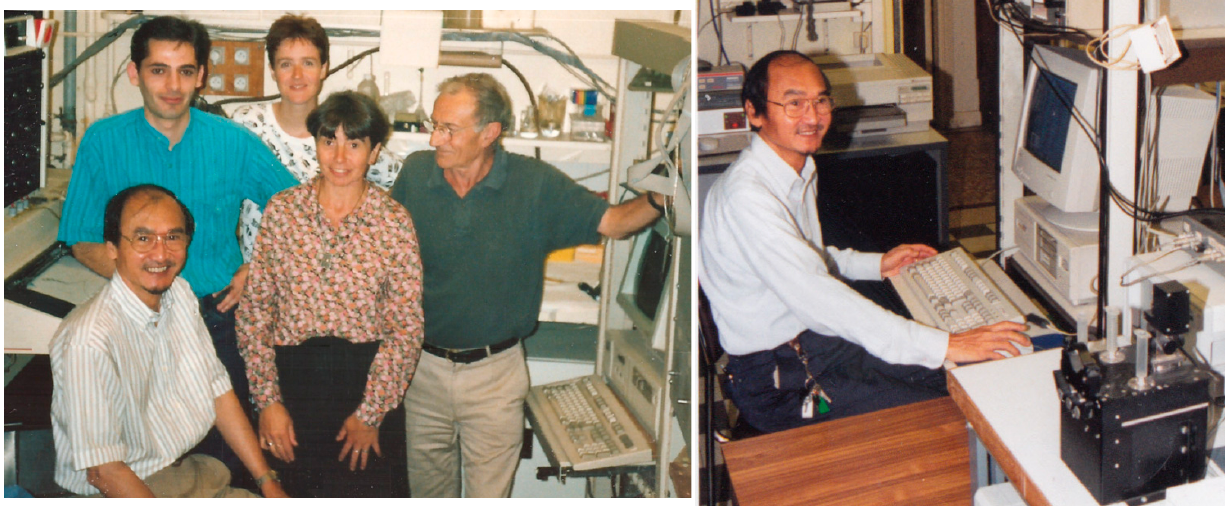
Figure 1. Gaston Hui Bon Hoa at the Institute of Physico-Chemical Biology (Paris, France). Left: Laboratory of Prof. Pierre Douzou (INSERM Unité 310). Front row: Gaston Hui Bon Hoa, Pascale Debey, Pierre Douzou. Back row: Carmelo Di Primo, Sylvie Le Bihan. Summer 1992, Paris, France. Right: Gaston Hui Bon Hoa at his workplace, November 1996.